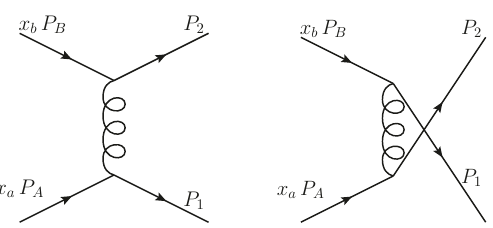
Figure 3 . Unpolarized scattering amplitudes for the qq → qq subprocess. From left the right, the scattering amplitude is provided for the t - and u -channel